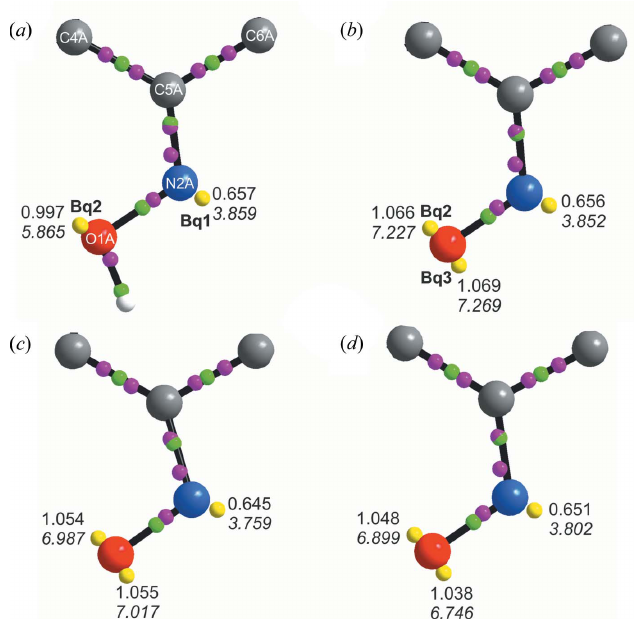
Figure 8 Laplacian CPs for ( a ) VA, ( b ) (II), ( c ) (III) and ( d ) (I). The values of charge density and negative Laplacian (shown in italic type) are given for all VSCC maxima. Small pink spheres represent VSCC maxima and small green spheres represent BCPs.